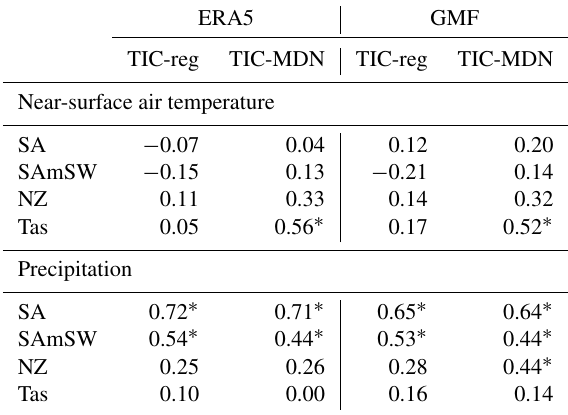
Table 2. Pearson correlation coefficient between the reconstructed as well as GMF and ERA5 near-surface air temperature and precip- itation over 1979–2000CE for different DA experiments with both ice core and tree-ring proxies (Table 1) and for different regions (Sect. 3). SA stands for South America, SAmSW for the southwest- ern border of South America in the Andes where the TRW proxy sites are located, NZ for New Zealand and Tas for Tasmania. Aster- isks stand for significant correlation coefficients at the 95% confi- dence level.